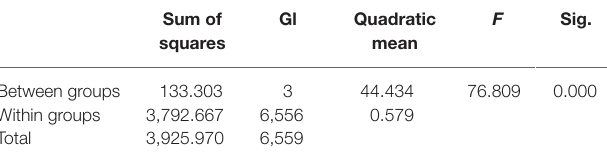
TABLE 11 | ANOVA test between cognitive level and historical contents. Sum of Gl Quadratic F squares mean